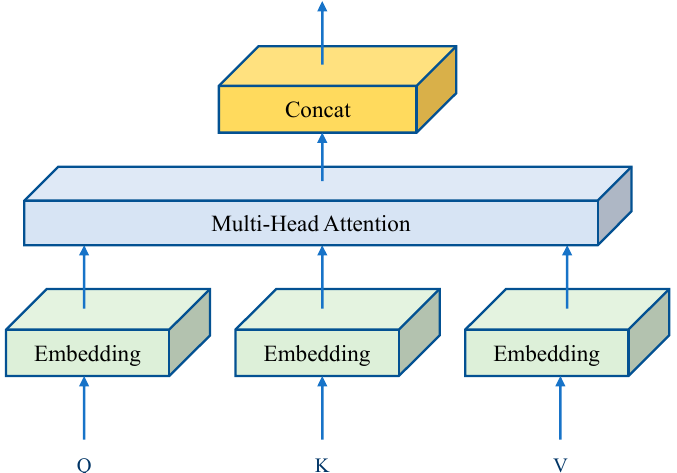
Figure 2. The structure of Transformer model.